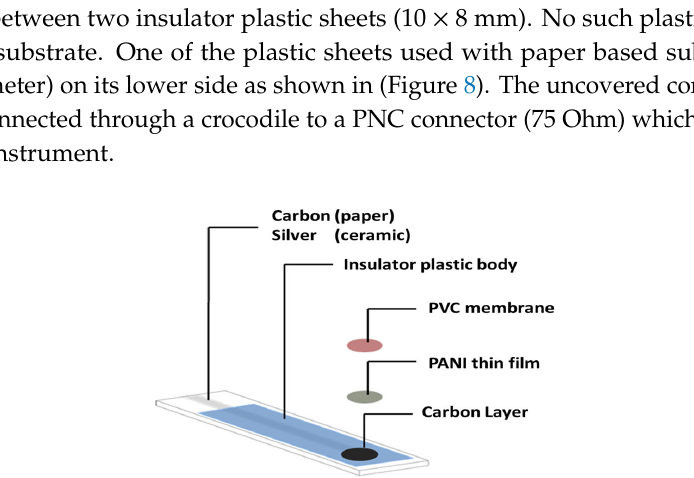
Figure 8. Fabrication of paper and ceramic based chromium (VI) sensors with PANI solid